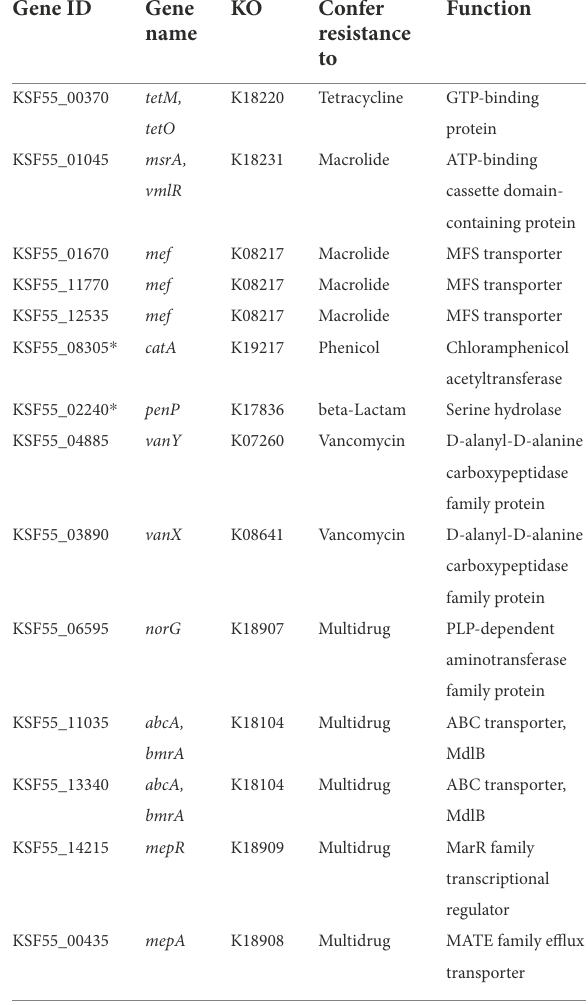
TABLE 3 List of putative AMR genes identified by KEGG